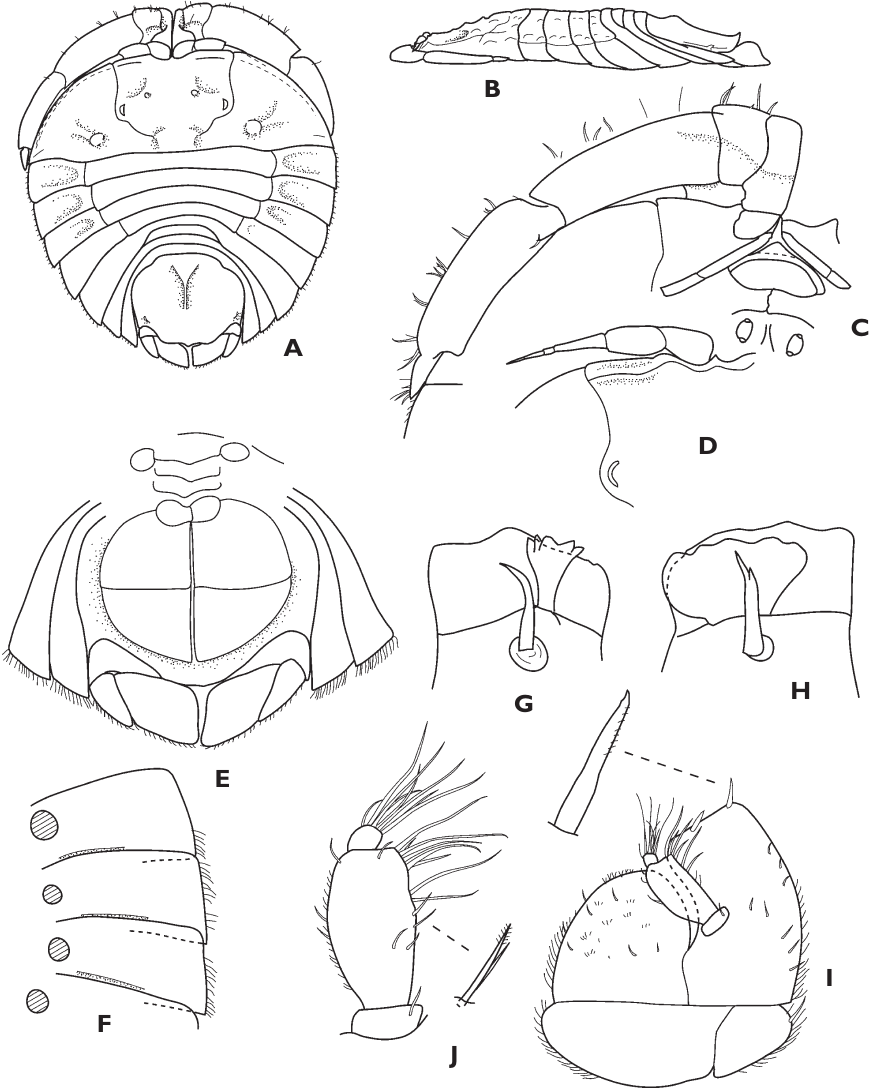
Figure 25. Th ysanoserolis orbicula sp. n. Holotype. A dorsal view B lateral view C head, frons and antennae, ventral view D head, anterior margin E pleon and pleotelson, ventral view F coxae 2–5, ventral G right mandible H left mandible I maxilliped J maxilliped